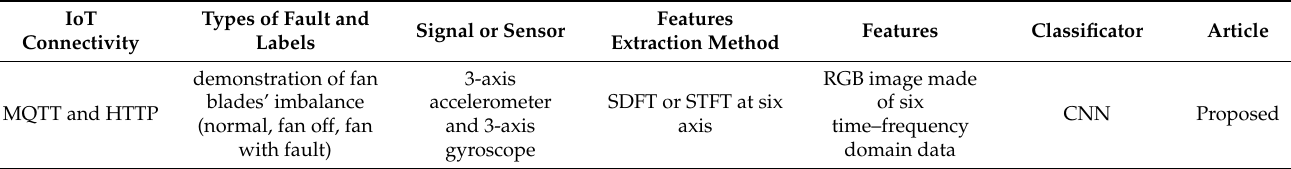
Table 1. Comparison of proposed and enhanced